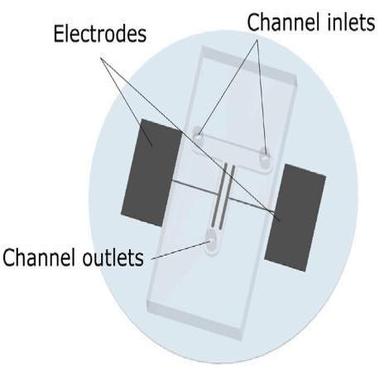
Three-dimensional view of the MFC.